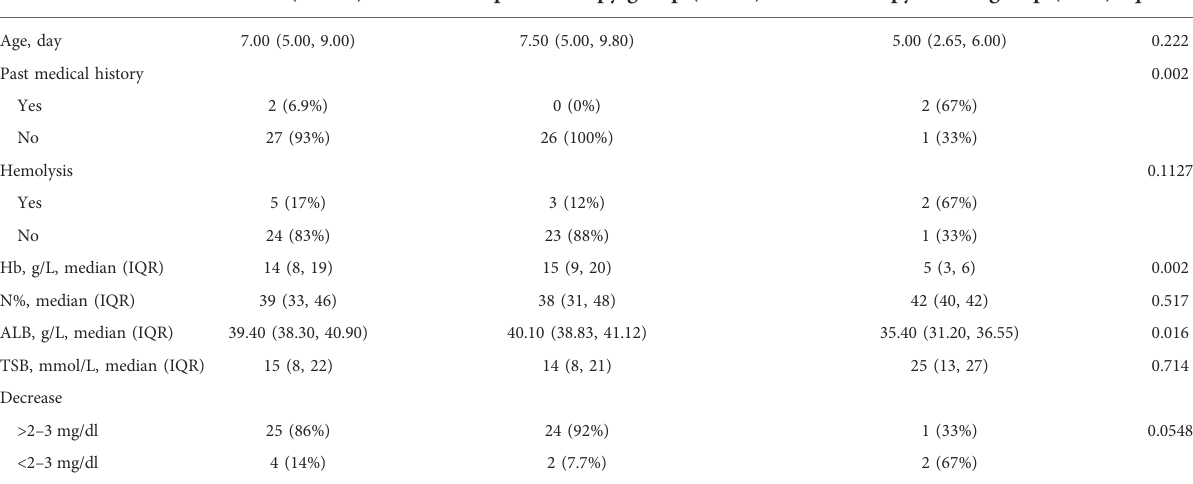
TABLE 2 Demographic and clinical characteristics of newborns in validation cohort: Children ’ s Hospital of Soochow University ( N =29).